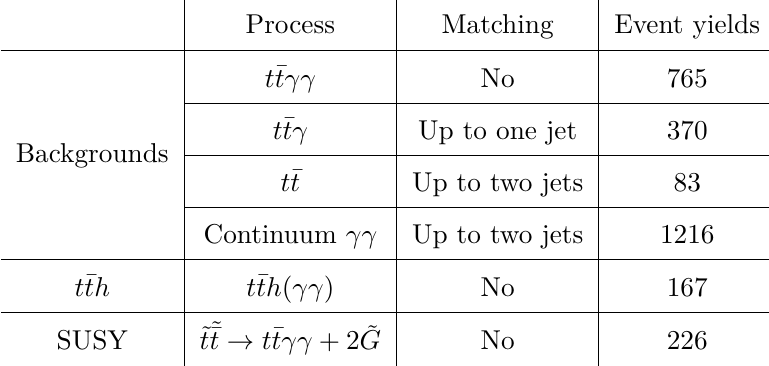
Table 2 . Expected events yields after preselection, assuming 3 ab − 1 at